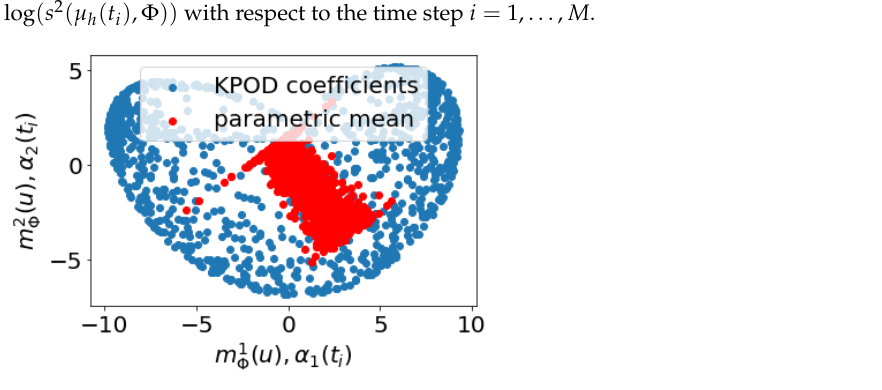
Figure 18. (Data-targeted VAE) In red, the parametric plot of the two components of the data-targeted m ( u h ( t i ) , Φ ) , i = 1, . . . , M . In blue, the parametric plot of the two components of α ( t i ) , i = 1, . . . , M